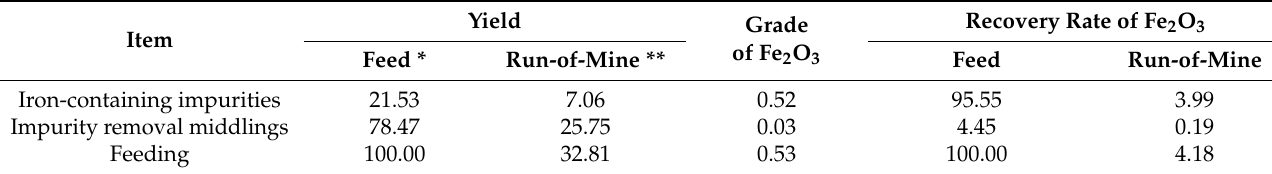
Figure 9. Flotation flowsheet for recovery of feldspar and purification of quartz.